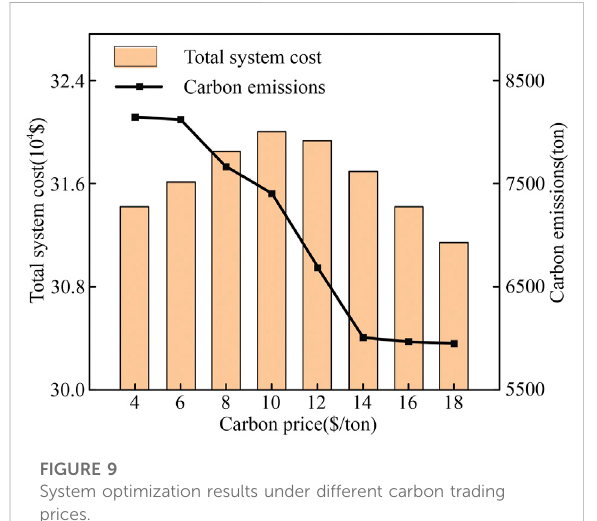
FIGURE 9 System optimization results under different carbon trading